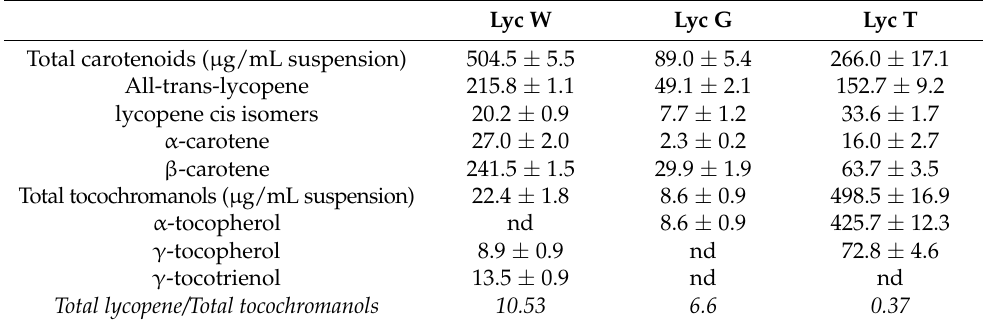
Table 1. Biochemical composition of Lyc W, Lyc G and Lyc T oleoresin/ α -CD suspensions. Lyc W Lyc G Total carotenoids ( µ g/mL